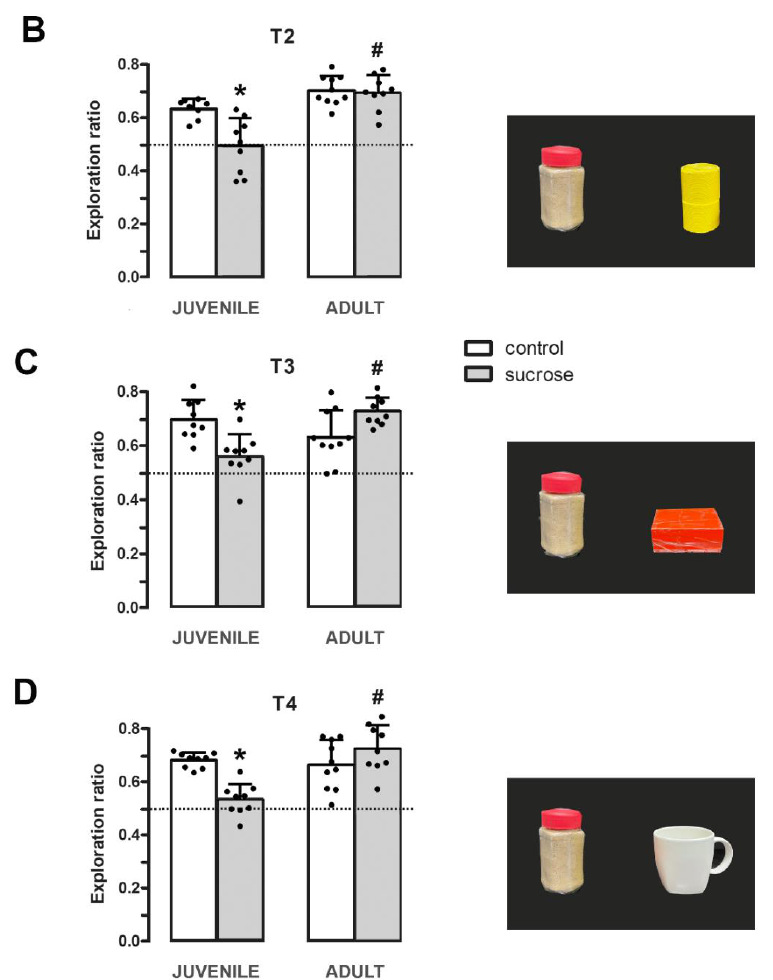
Figure 2. Long-term effect of unlimited sucrose consumption on learning ability. The NOR task was performed 25 days after sucrose treatment both in juvenile and adult animals. ( A ) Time spent exploring the objects during the sample phase (T1). ( B – D ) Exploration ratios during the choice phase of the NOR trials (T2–T4). Juvenile or adult rats exposed to only water (control, white bars) or 10% (w/v) sucrose (sucrose, gray bars). Note that adult animals from the sucrose-exposed juvenile group show impaired acquisition and consolidation of the object trace. Data are presented as mean ± SD from two independent experiments, n = 9–10. Tukey’s post hoc test showed differences by treatment, * p < 0.05 and by age, # p < 0.01 juvenile group vs. adult group (T1), and sucrose-exposed juvenile group vs. sucrose-exposed adult group (T2–T4). Dotted lines show the exploration rate at the value